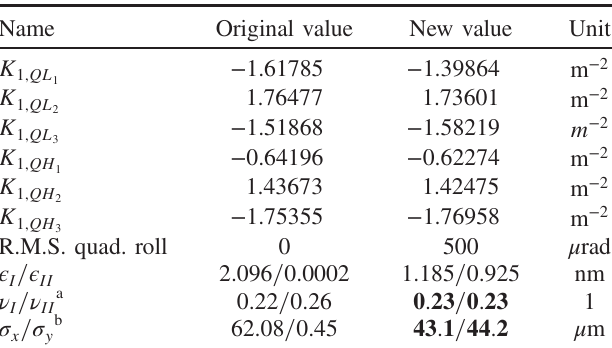
TABLE I. Parameters from flat beam to round beam with on- resonance tune.